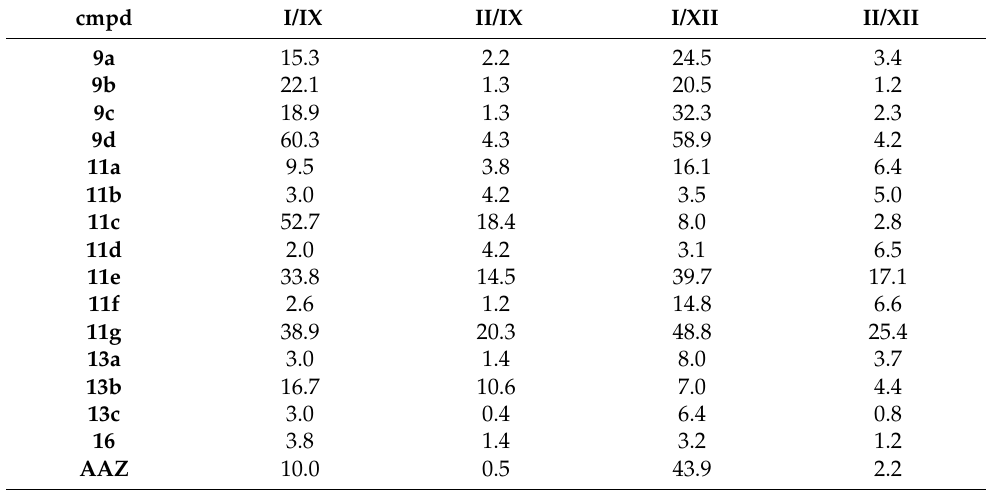
Table 2. Selectivity ratios for the inhibition of hCA IX and XII over hCA I and II for target compounds 9a – d , 11a – g , 13a – c and 16 .